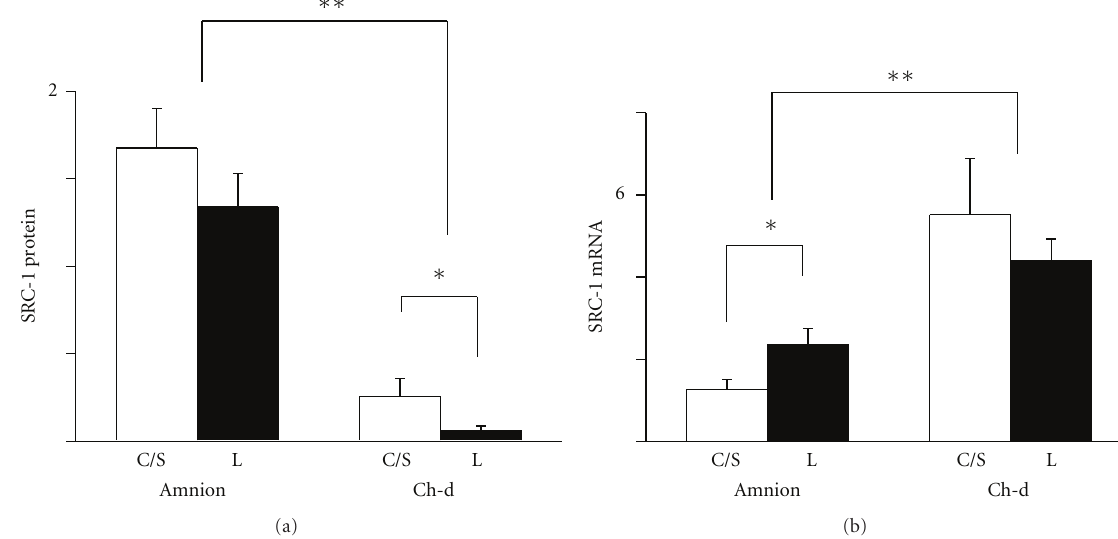
Figure 2: Expression of SRC-1 protein (a) and mRNA (b) in the amnion and chorion-decidua (Ch-d) from non-labor group (C/S) and labor group (L). Data were presented as the mean ± SEM. (a) ∗∗ P < 0 . 05 between amnion and chorion-decidua. ∗ P < 0 . 05 between C/S group and labor group within the chorion-decidua. (b) ∗∗ P < 0 . 05 between amnion and chorion-decidua. ∗ P < 0 . 05 between C/S group and labor group within the amnion. Ponceau S staining was used as the internal control for Westerns and GAPDH mRNA as the internal control for mRNA.